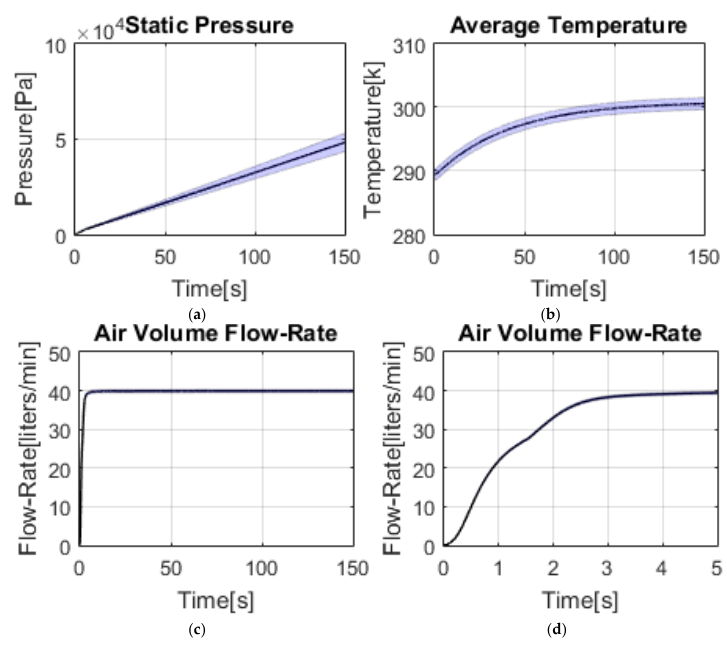
Figure 14. ( a ) Description of the pressure increase inside STARDUST-U during the air flow inlet at 40 L/min. ( b ) Description of the temperature variations measured during the experiment. ( c ) Description of the flow rate variation in the time. ( d ) Flow rate increase in the early stage from the accident experimental simulation. The results of pressure variations, flow rate variations and temperature variation obtained for vale F are comparable to those obtained for valve E.